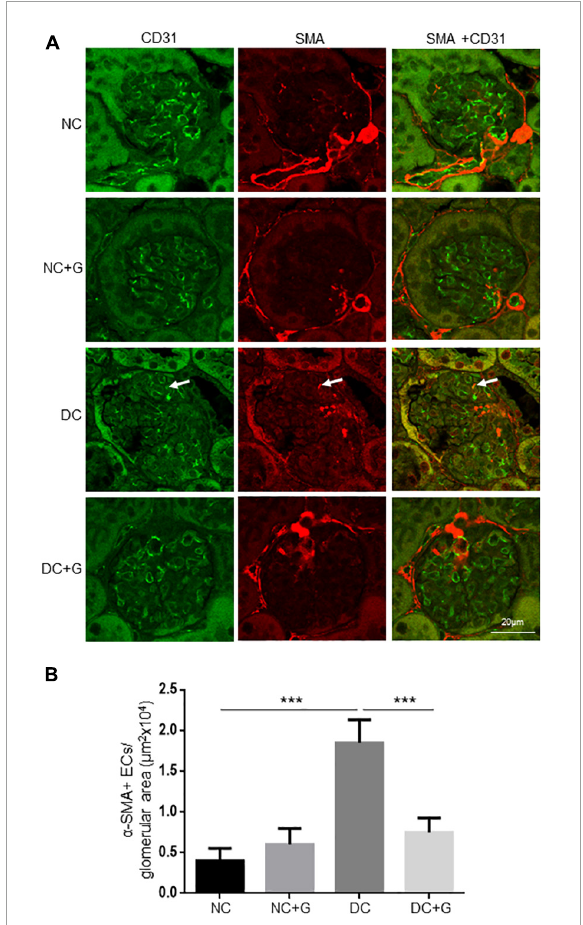
FIGURE6 Glucosamine decreases the number of α -SMA+ endothelial cells in diabetic nephropathy. (A) Representative images are shown from double immunofluorescence staining with α -SMA and marker for endothelial cells CD31. (B) Quantification of α -SMA+ endothelial cells normalized to the glomerular areas (20 glomeruli analyzed per kidney). The experiments were repeated in 3 kidneys each group. Arrows indicate the illustrative co-localization of α -SMA and CD31. Data are shown in mean ± SEM. n = 20. *** p <